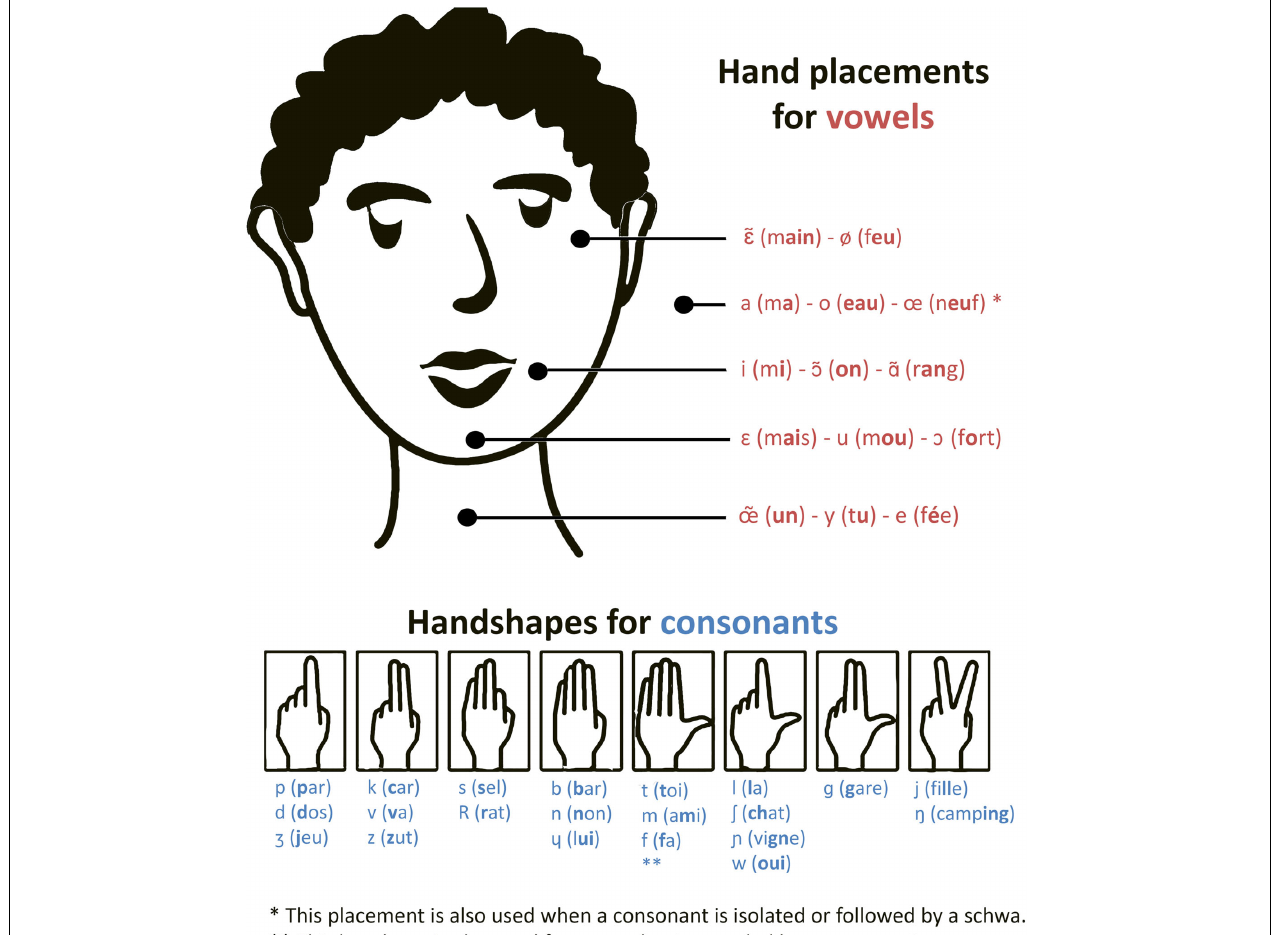
FIGURE 1 | Cues in French Cued Speech: hand-shapes for consonants and hand placements for vowels. Adapted from http://sourdsressources. wordpress.com.